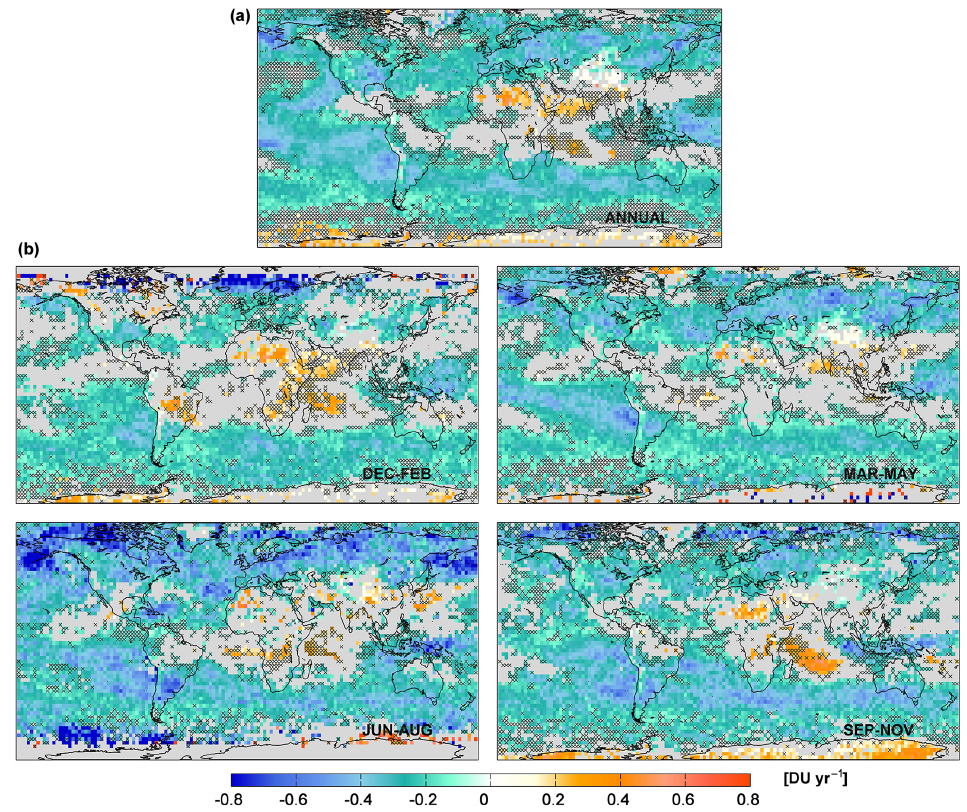
Figure 5. (a) Annual and (b) seasonal distributions of the adjusted trends in DUyr − 1 from the multi-linear regression models. The grey areas and crosses refer to the non-significant grid cells in the 95% confidence limits (2 σ